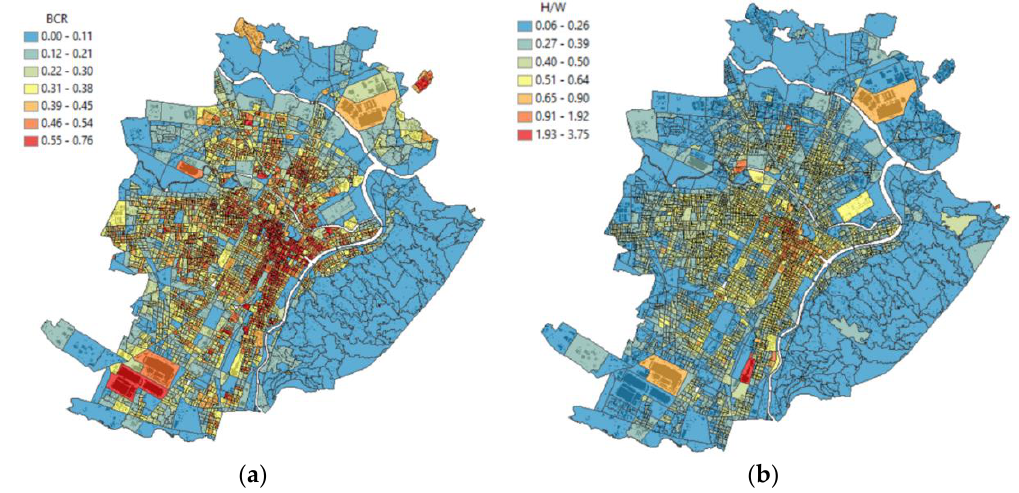
Figure 5. Morphological parameters of Turin: ( a ) the building coverage ratio BCR (BCR avg = 0.33) and ( b ) the canyon effect H/W (H/W avg = 0.41) calculated through the use of the building characteristics at a census section scale.